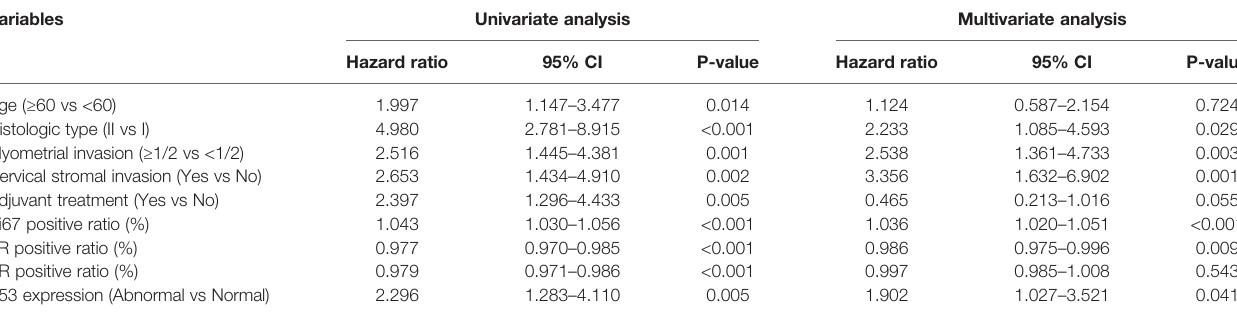
TABLE 3 | Univariate and multivariate analysis of factors predicting EC recurrence in the training cohort.